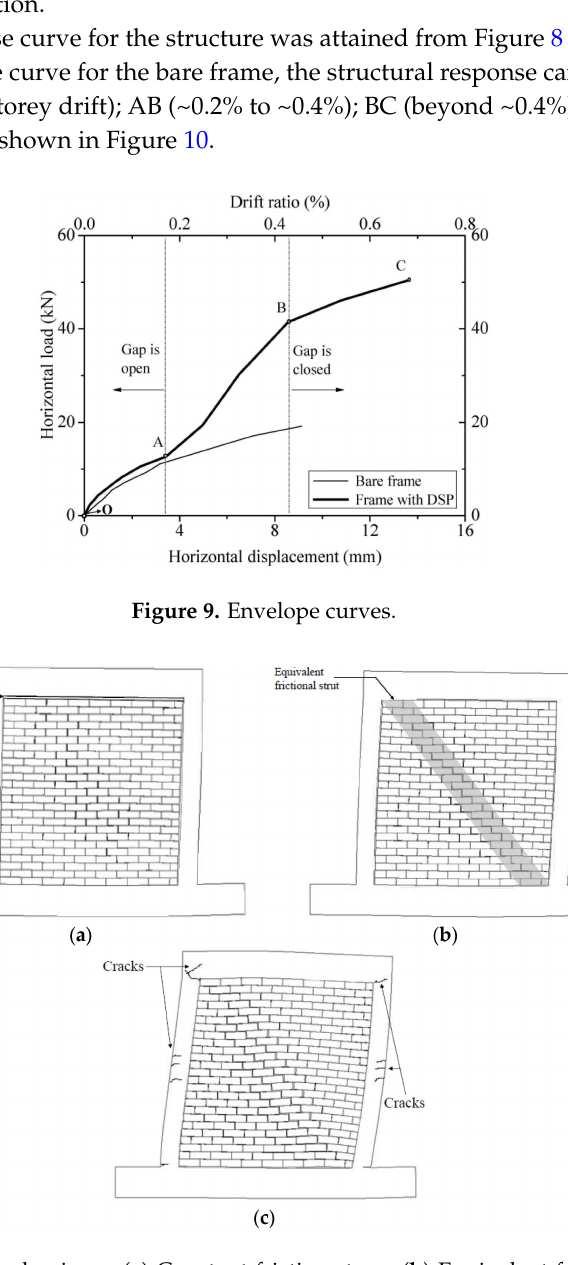
Figure 10. Response mechanisms: ( a ) Constant friction stage; ( b ) Equivalent frictional strut stage; ( c ) Plastic